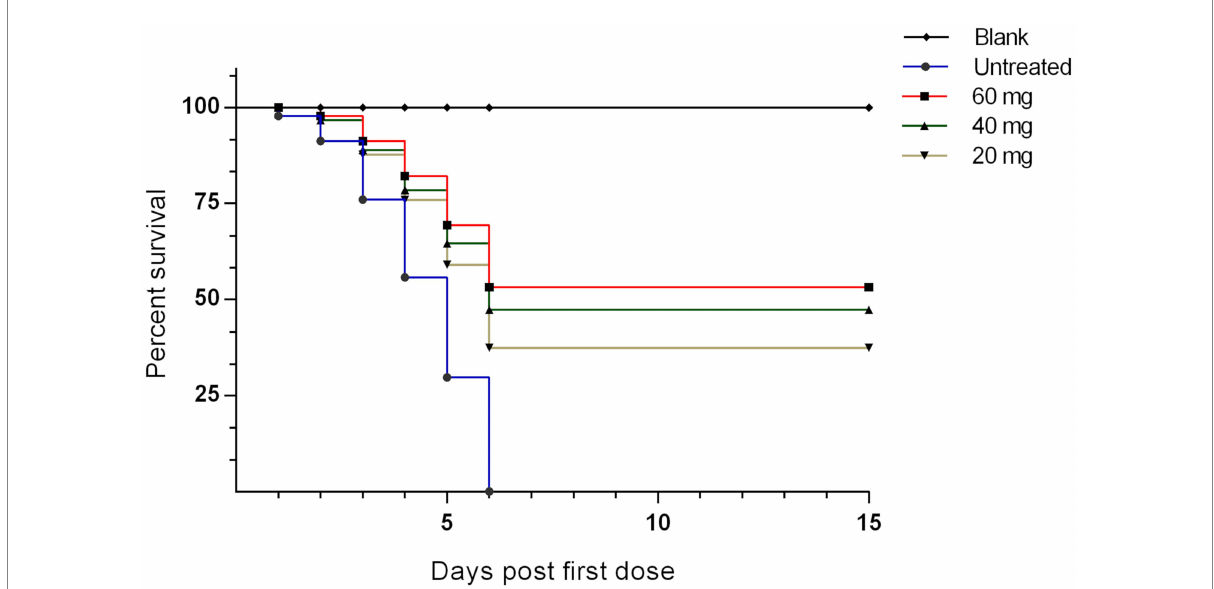
FIGURE 2 The survival rate of experimentally NDV infected chickens during and after treatment with 20, 40, and 60 mg/k.g BW n -docosanol. The number of alive chickens in each group was recorded at 1–15 days post the first n -docosanol dosage injection. The survival rate was graphed using GraphPad Prism version 6.01 and analyzed by Kaplan–Meier estimator with Logrank test. A significant difference ( value of p of <0.001) appeared between the untreated group and both the high (60 mg/kg) and medium (40 mg/kg) dosage